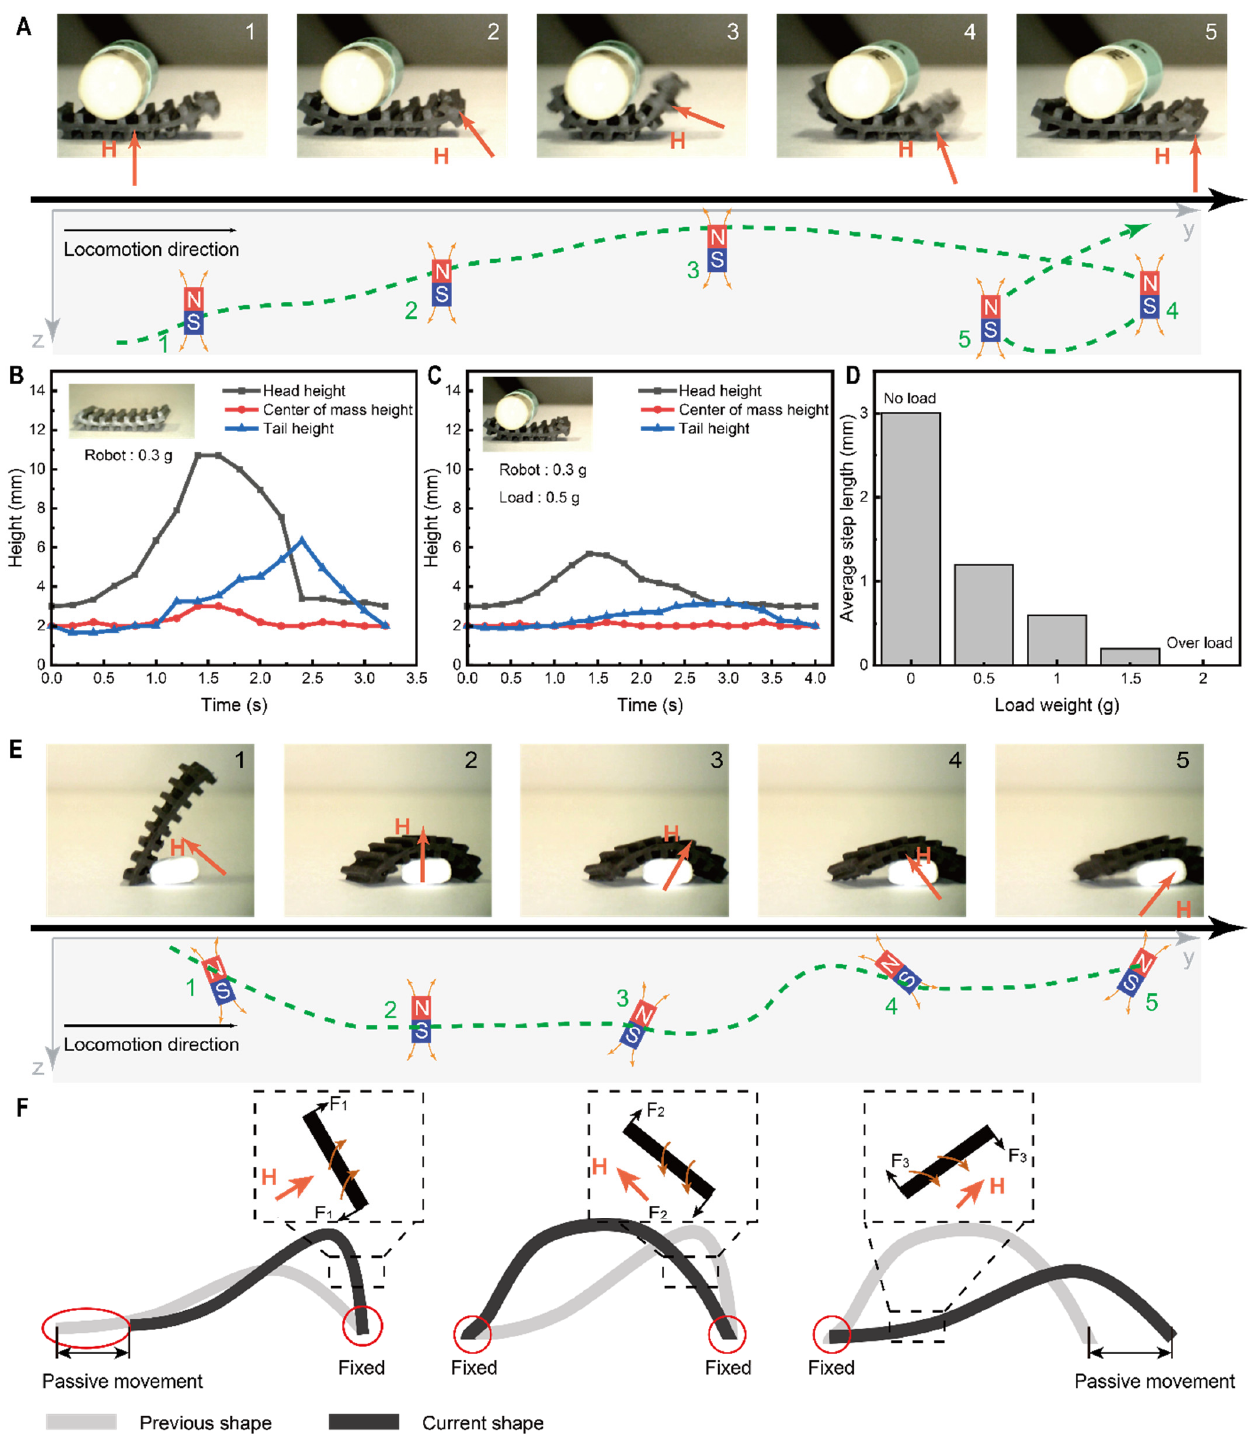
Figure 4. Locomotion analysis of soft robot motion based on imitation of an inchworm and snail. ( A ) Soft robot carrying a capsule that mimics the wriggling of a snail and its corresponding magnetic